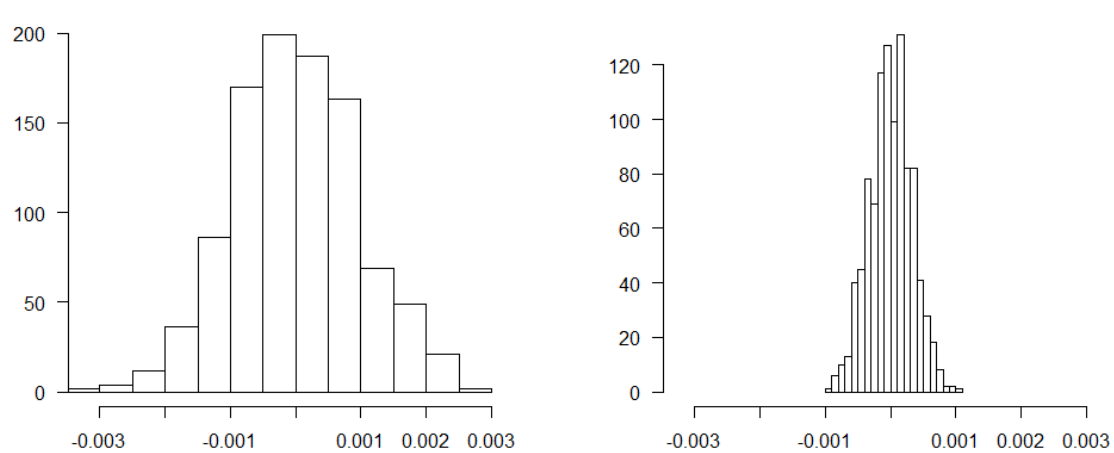
Figure 10. Histogram of measurements around its mean. On the left, the histogram of the measurements in the loudest direction. On the right side, the histogram of measurements in the normal direction.